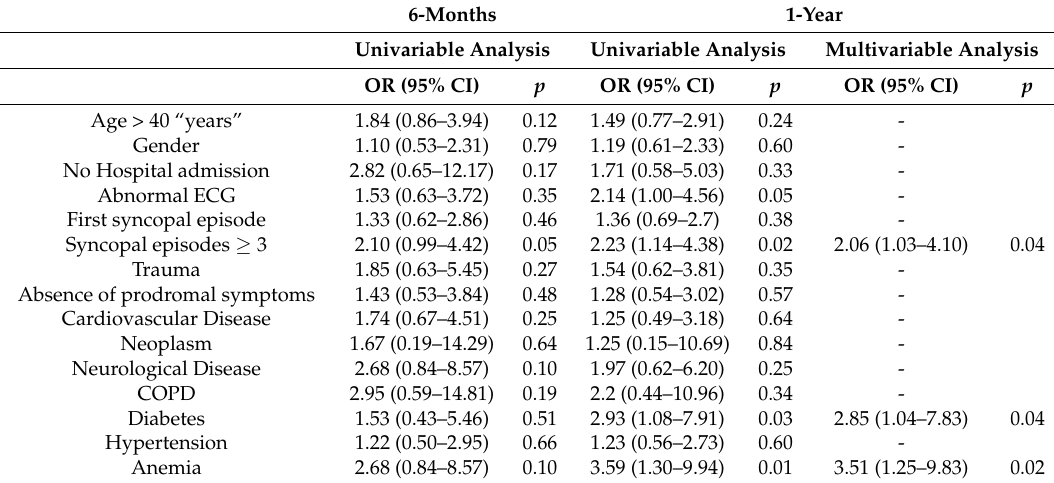
Table 2. Predictors of syncope recurrence within 6 months and 1 year from syncope index